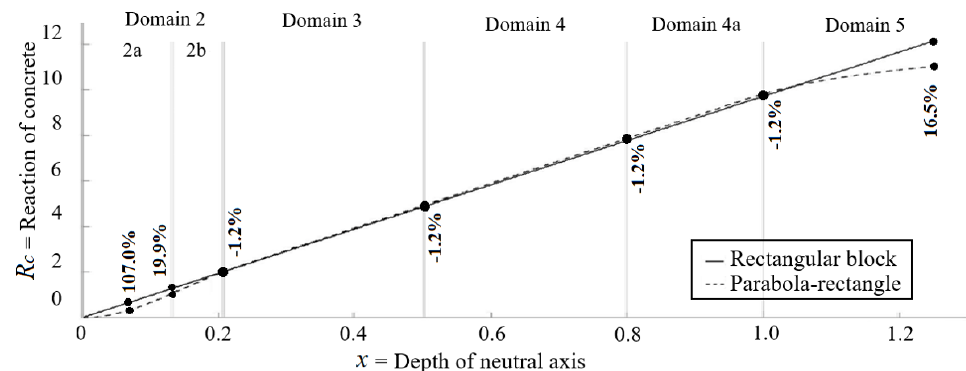
Figure 6. Internal reactions for concrete class C20 ( f ck = 20 MPa). The percentage di ff erence between the two approaches is marked at some representative points, referred to results obtained with the parabola-rectangle diagram.